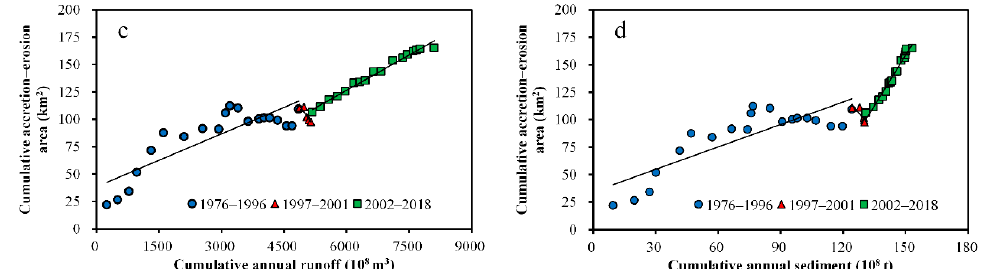
Figure 9. Relationship between the cumulative accretion–erosion area of the estuary and the cumulative annual runoff and sediment from 1976 to 2018. ( a ) for the Yellow River Estuary and the cumulative annual runo ff ; ( b ) for the Yellow River Estuary and the cumulative annual sediment; ( c ) for the Qing 8 estuary and the cumulative annual runo ff ; ( d ) for the Qing 8 estuary and the cumulative annual